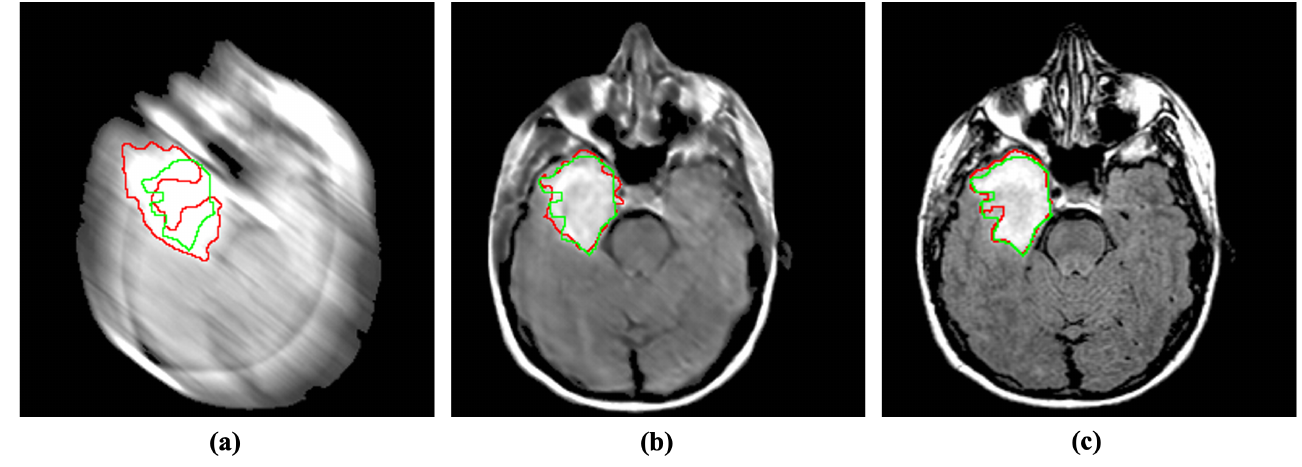
Figure 6. Incorporating the proposed method for deblurring medical images can improve medical im- age segmentation performance. The red and green regions represent the area segmented by the deep model and the actual (ground-truth) affected region. ( a ) Blurry image + U-Net [36]. ( b ) Deblurred image obtained by proposed method + U-Net [36]. ( c ) Reference image + U-Net